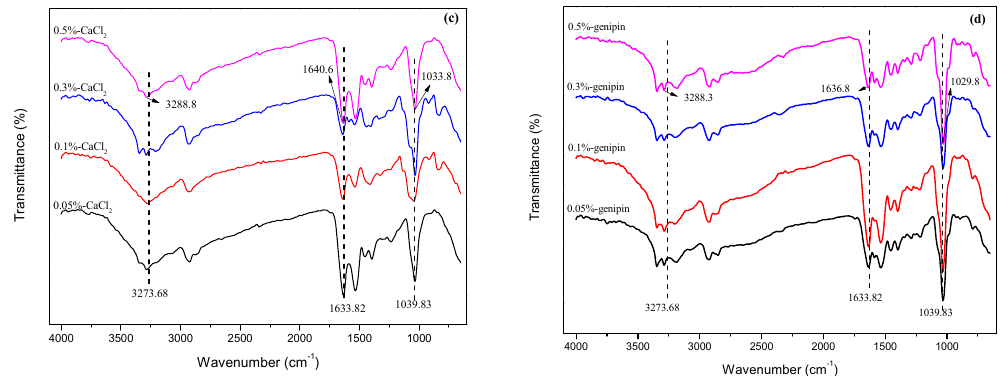
Figure 2. Fourier transform infrared (FTIR) spectra of ( a ) P-40-25, ( b ) P-40-25 cross-linked by TG, ( c ) P-40-25 cross-linked by CaCl 2 , and ( d ) P-40-25 cross-linked by genipin.